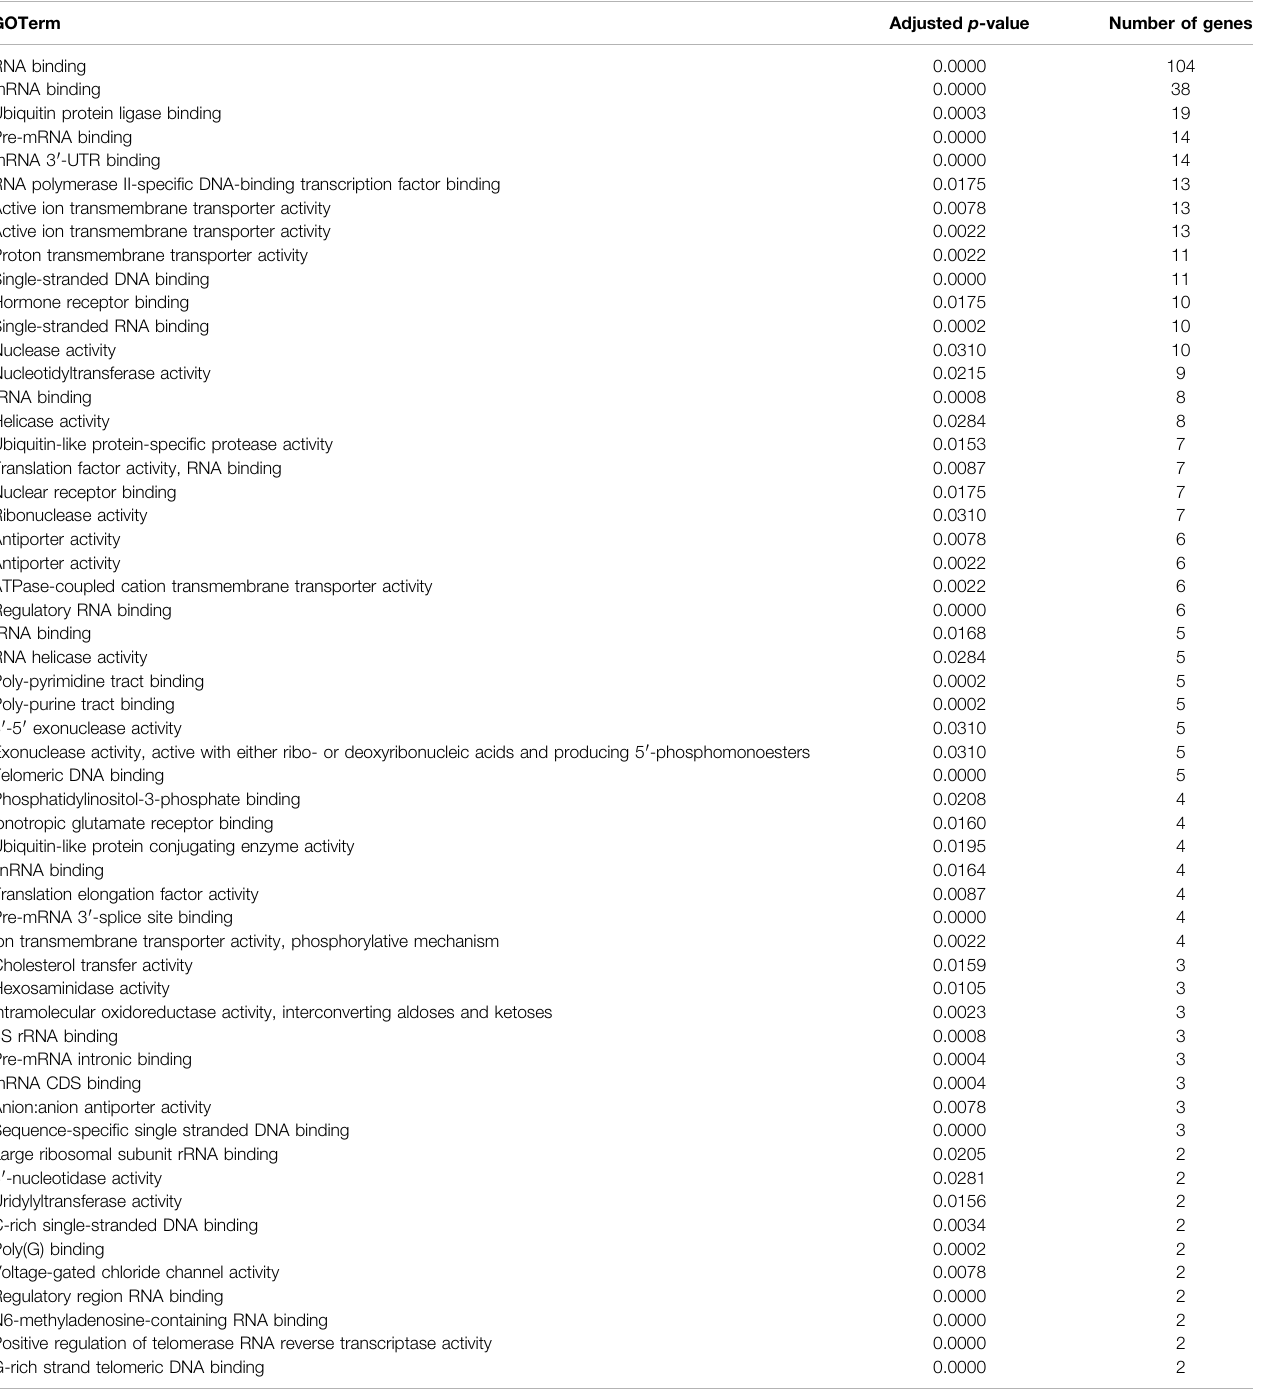
TABLE 2 | GO term analysis for AS-NMD regulated genes in mouse.